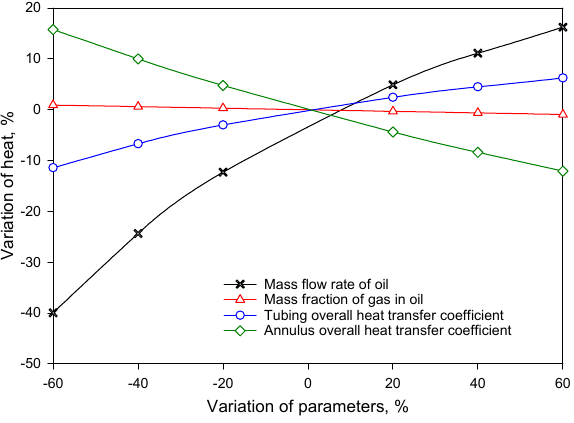
Figure 6. Sensitive analysis for temperature variation in the annulus. Table 4. Influence of Factors on Temperature in the Annulus.